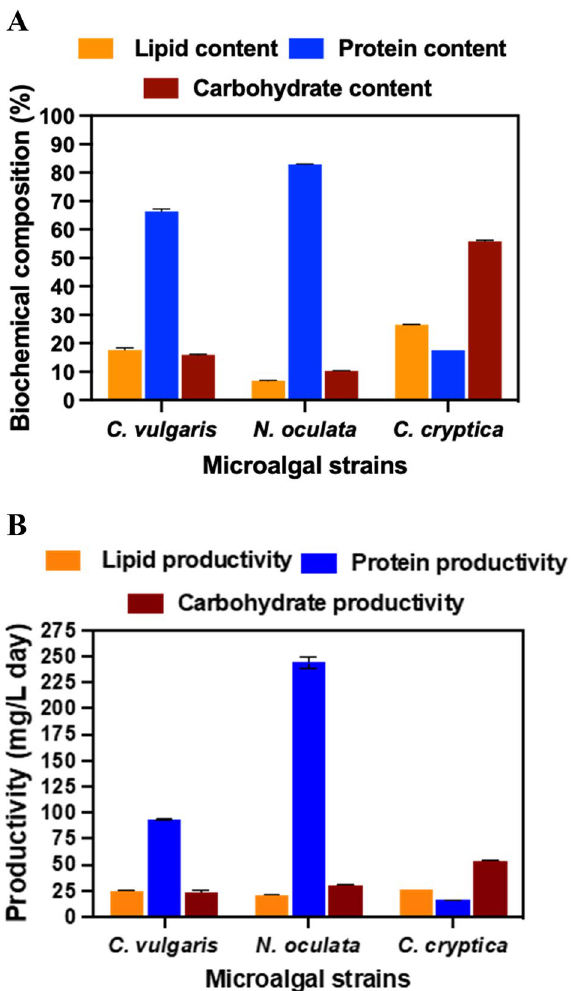
Figure 2. ( A ) Biochemical composition (%); and ( B ) productivity (mg/L d) of C. vulgaris , N. oculata, and C. cryptica cultivated in